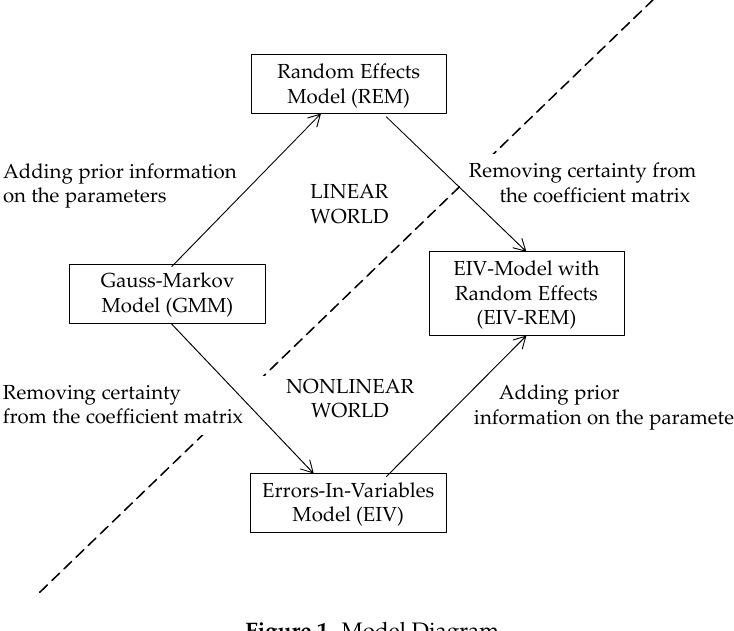
Figure 1. Model Diagram.